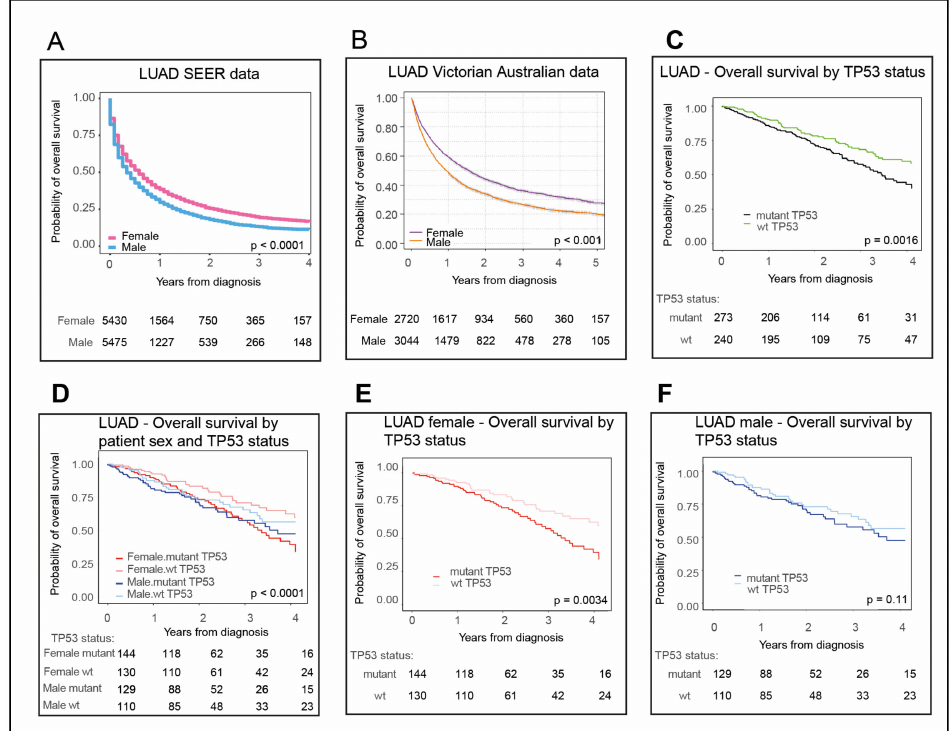
Figure 1. Females with lung adenocarcinoma (LUAD) and wild type (wt) TP53 outlive other LUAD patients. Overall survival data for LUAD ( A ) male (blue) and female (pink) patients from US Surveillance, Epidemiology, and End Results Program (SEER) data (2012–2016) and ( B ) male (orange) and female (purple) patients from Australian Victorian data (2013–2017). LUAD patient overall survival in The Cancer Genome Atlas (TCGA), ( C ) according to either wt TP53 (green) or mutant TP53 status (black); then for ( D ) females stratified for wt TP53 (pink) and mutant p53 status (red) and males stratified for wt TP53 (light blue) and mutant TP53 status (dark blue). Also shown separately for ( E ) women and ( F ) men. The numbers of patients corresponding to each cohort are tabulated below each plot. ‘p ’ is the p-value for di ff erences in survival time between cohorts (significant p -value < 0.05). Refer to Section 4. Materials and Methods for description of methodology and datasets utilized in survival